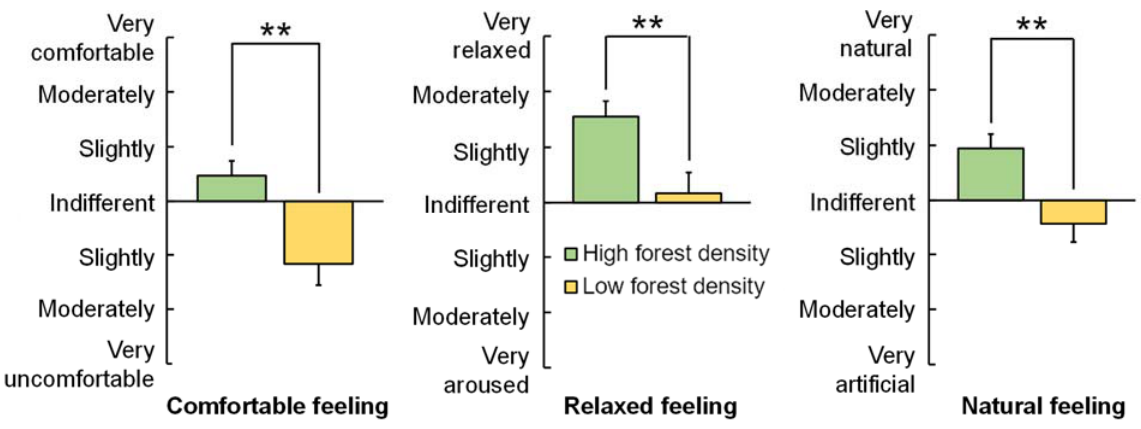
Figure 12. Comparison of semantic differential (SD) method scores in the “after exercise” between high forest density and low forest density. Changes in the subjective feelings of “comfortable”, “relaxed”, and “natural”. N = 18, mean ± standard error. ** p < 0.01 using the Wilcoxon signed-rank test.